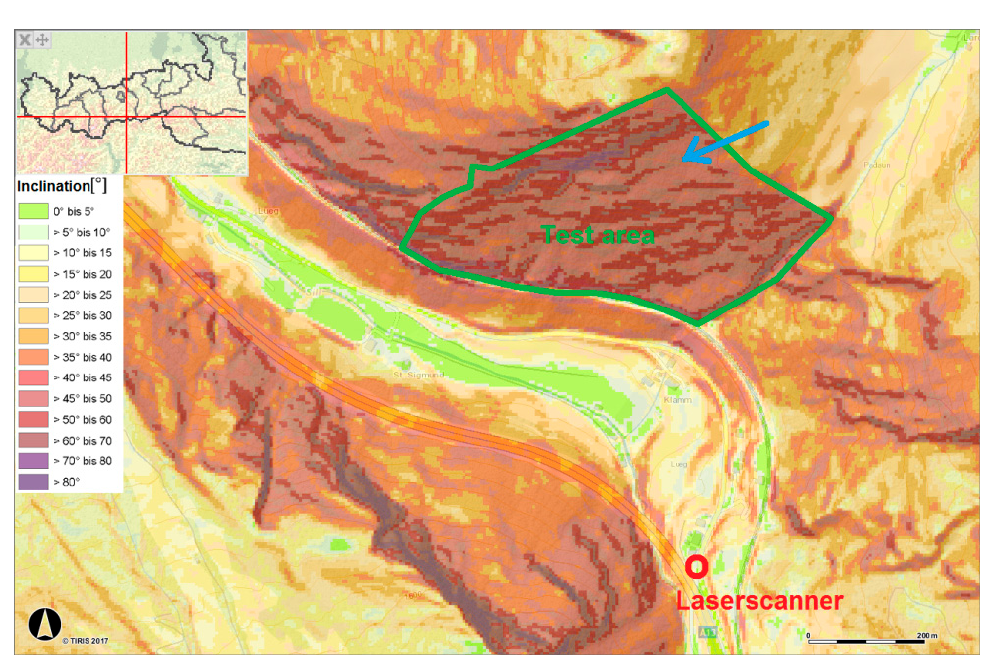
Figure 7. Test area (inclination map); image source: © Land Tirol, tiris, www.tirol.gv.at/tiris.